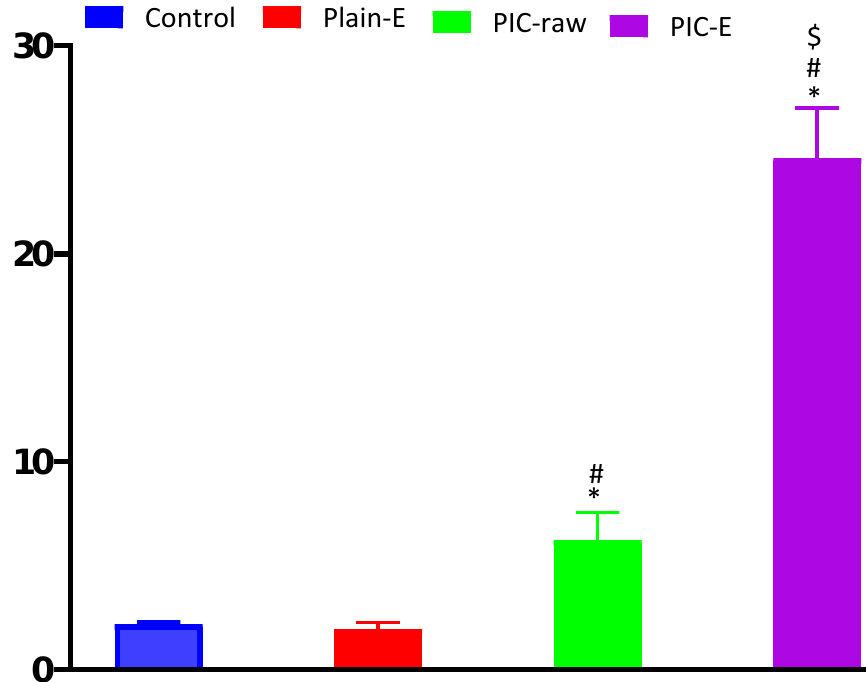
Figure 9. Effect of PIC-E on cleaved caspase-3 content in HCT 116 cells. Cells were incubated for 24 h with plain-E, PIC-raw (0.1 µM), or PIC- E (equivalent to 0.1 µM PIC) * Significantly different from control at p < 0.05. # Significantly different from plain-E at p < 0.05. $ Significantly different from PIC-raw at p < 0.05.